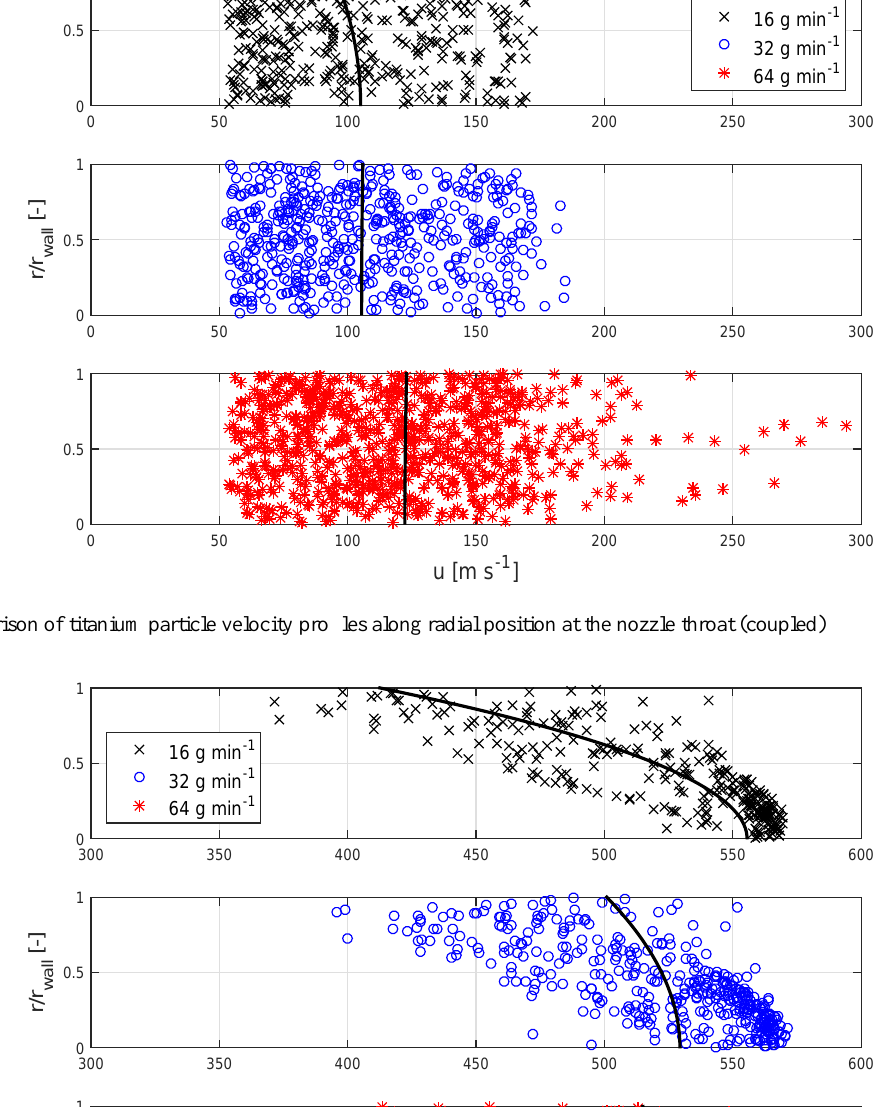
to 505 ms − 1 . Transferring this trend to the